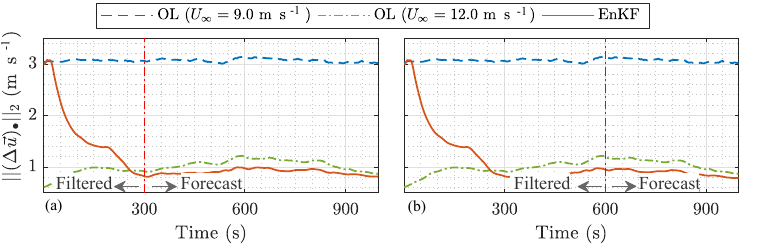
Figure 10. Comparison of flow field estimation for the nine-turbine case. Measurements are available until t = 300s (a) and t = 600s (b) , respectively. The EnKF converges to the true U ∞ after 300s. After convergence, the forecasts are significantly better than in open-loop